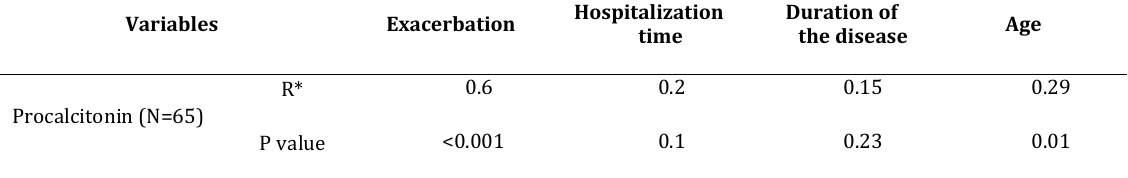
Hospitalization Duration of Age time the disease